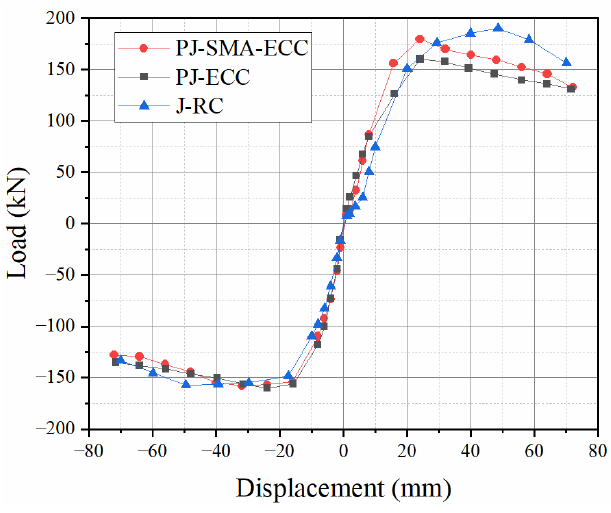
Figure 10. Skeleton curve of the specimens.